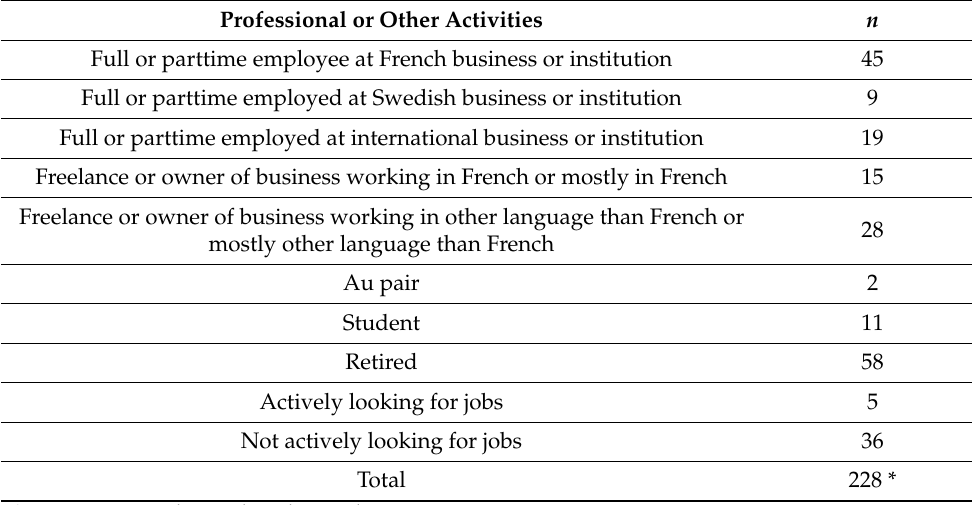
Table 2. Participants’ professional or other